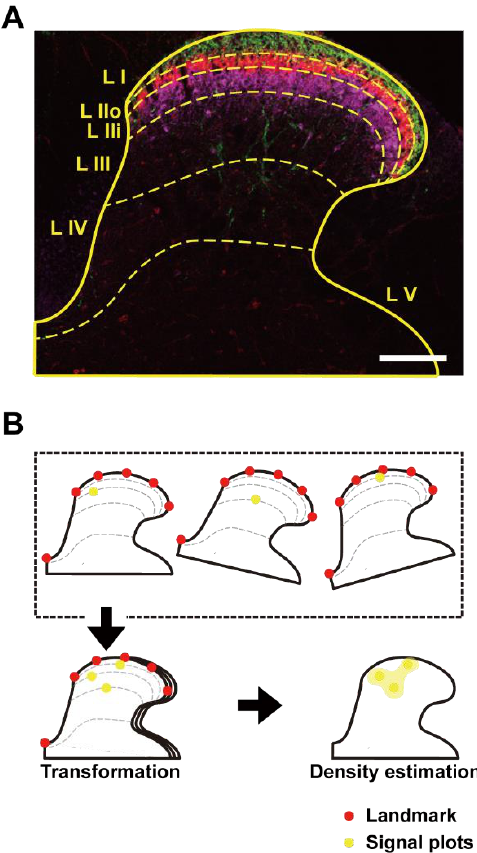
Figure 1. ( A ) Generation of a reference template for mouse dorsal horn with Rexed laminae delineated by immunofluorescence against CGRP (green) for lamina I, IB4 (red) for lamina IIo, and PKC- γ (purple) for lamina IIi. The scale bar indicates 100 µm. ( B ) Schematic of the transformation and spatial density estimation procedures. Initially, landmarks (red dots) were established at the central canal and equally spaced along the outer border of lamina I (upper dashed line enclosure). A piece-wise linear transformation was computed using these landmarks. This transformation was then used to map coordinates of the fluorescent signals (yellow dots) from each image into the reference spinal dorsal horn template (downward arrow). In a separate step, kernel density estimation was used generate a frequency map (rightward arrow).